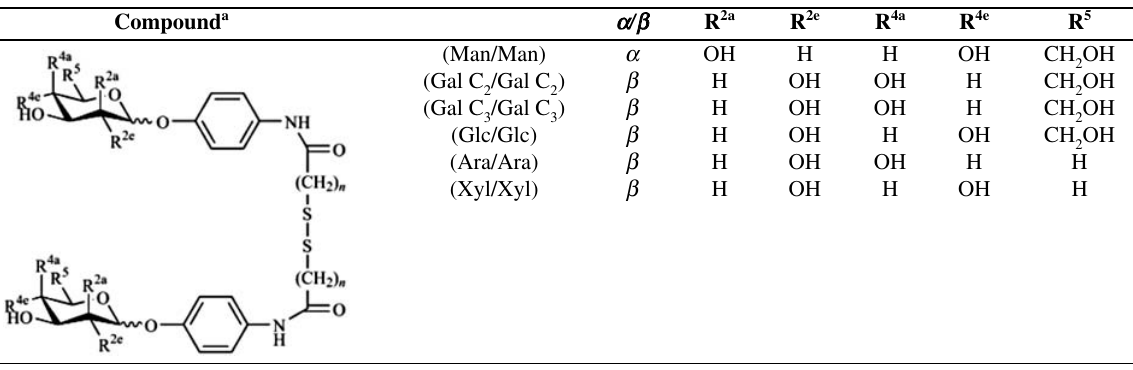
Table 1. Structures of the disulfide-linked carbohydrate dimers. 25